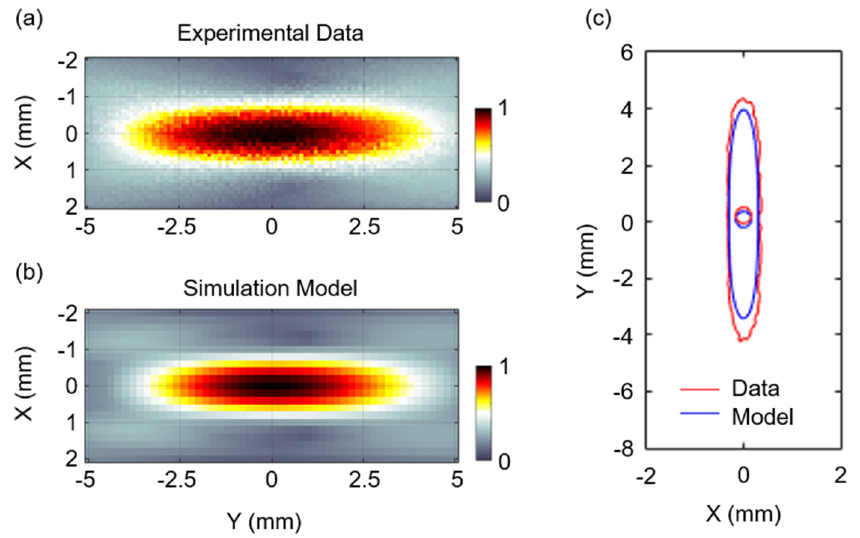
Figure 2. Normalized acoustic pressure distribution in a free water domain induced by FUS at 1.1 MHz in the ( a ) experiment and ( b ) simulation. The pressure − field distributions are centered at the peak points. ( c ) Comparison of the experimental and simulated data using FWHM contours and markers at the centroids of the contours.